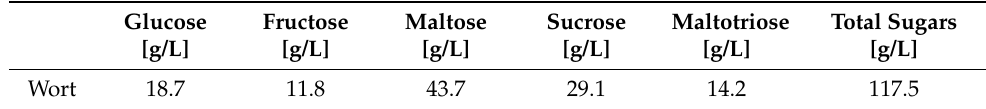
Table 1. Sugar content of rehydrated granmalt used in this study. Glucose Fructose Maltose Sucrose Maltotriose Total Sugars [g/L] [g/L] [g/L] [g/L] [g/L] [g/L] Wort 18.7 11.8 43.7 29.1 14.2 117.5 For sporulation, assays cells were precultured in liquid YPD, centrifuged and washed with sterile water and then streaked out on solid sporulation media (2% potassium acetate, 2% agar; pH 6.5–7.0). Plates were incubated for 10 days at 25 ◦ C before determining the